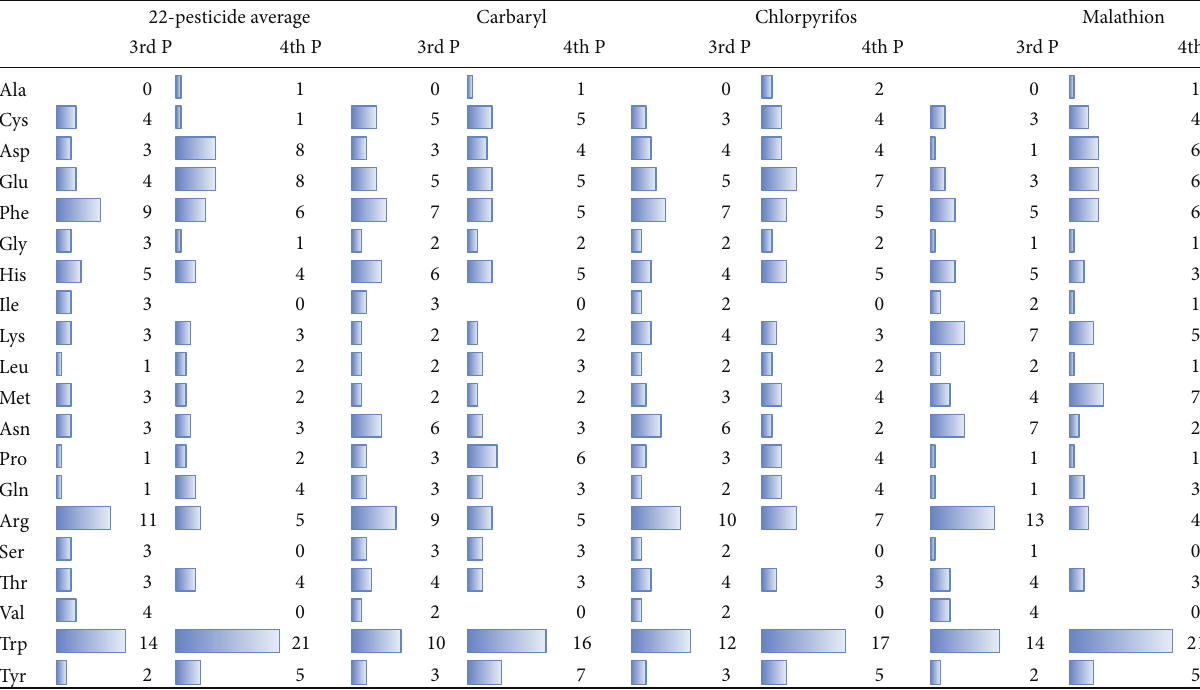
Figure 3: Amino acids occurrences in third and fourth position of the top 80 ranked hexapeptides (10% of the hexapeptides library) binding all 22 pesticides, carbaryl, chlorpyrifos, and